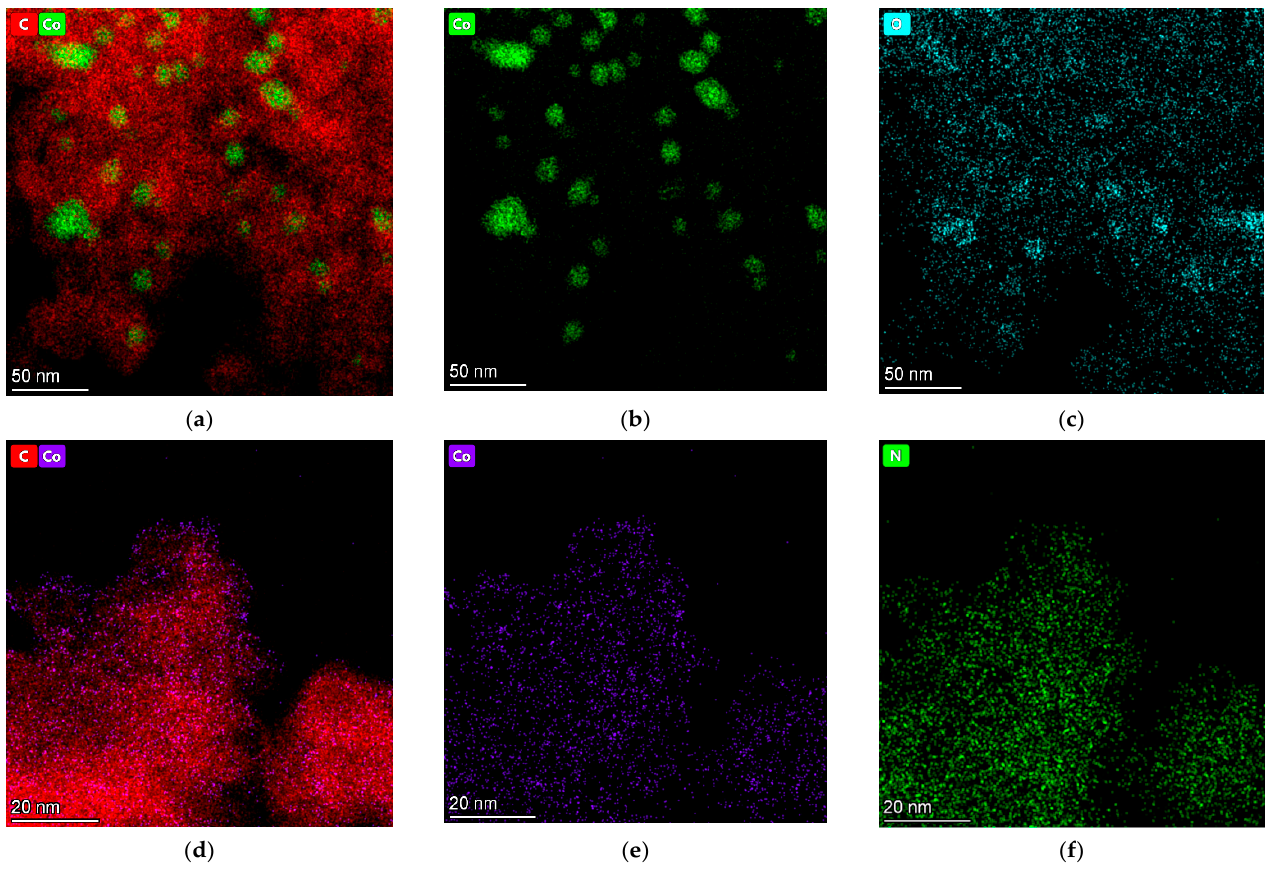
Figure 3. Selected EDX-STEM mapping images of Co@NC-ZIF SA : ( a – c ) mixed C/Co, Co and O elements of a fragment containing CoO x ; ( d – f ) Co/C, Co and N elemental mapping of the catalyst area free from Co and CoO x nanoparticles.